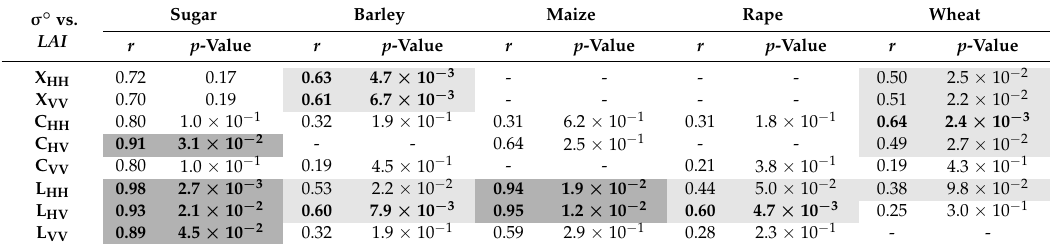
Table 6. r of σ ◦ vs. LAI for plots covered by vegetation. Significant correlations are highlighted in light-grey; strong and significant correlations are also bolded; very strong and significant correlations are highlighted in dark-grey with values in bold; very weak correlations are not reported. σ ◦ vs. LAI